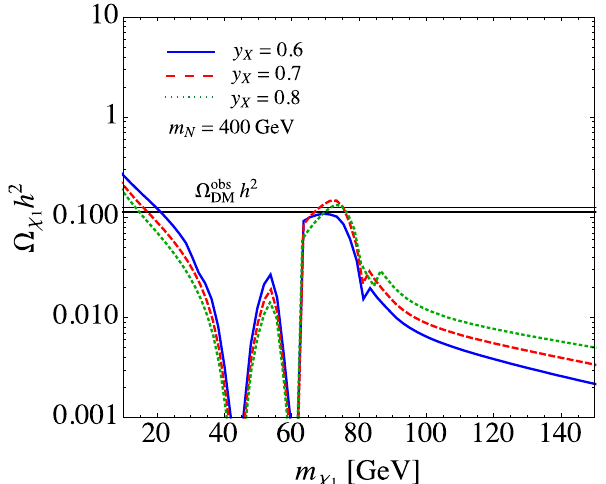
for y X = 0 : 6 (solid), y X = 0 : 7 (dashed), 1